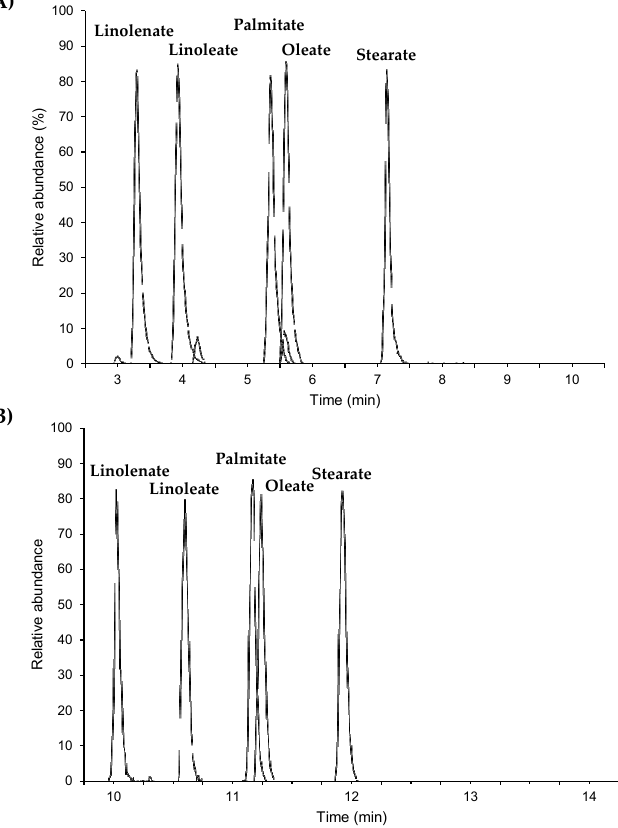
Figure 1. Typical LC-MS/MS chromatogram of GEs and 3-MCPDEs standard sample. ( A ) GEs standard sample (1 ppm) and ( B ) 3-MCPDEs standard sample (1 ppm).